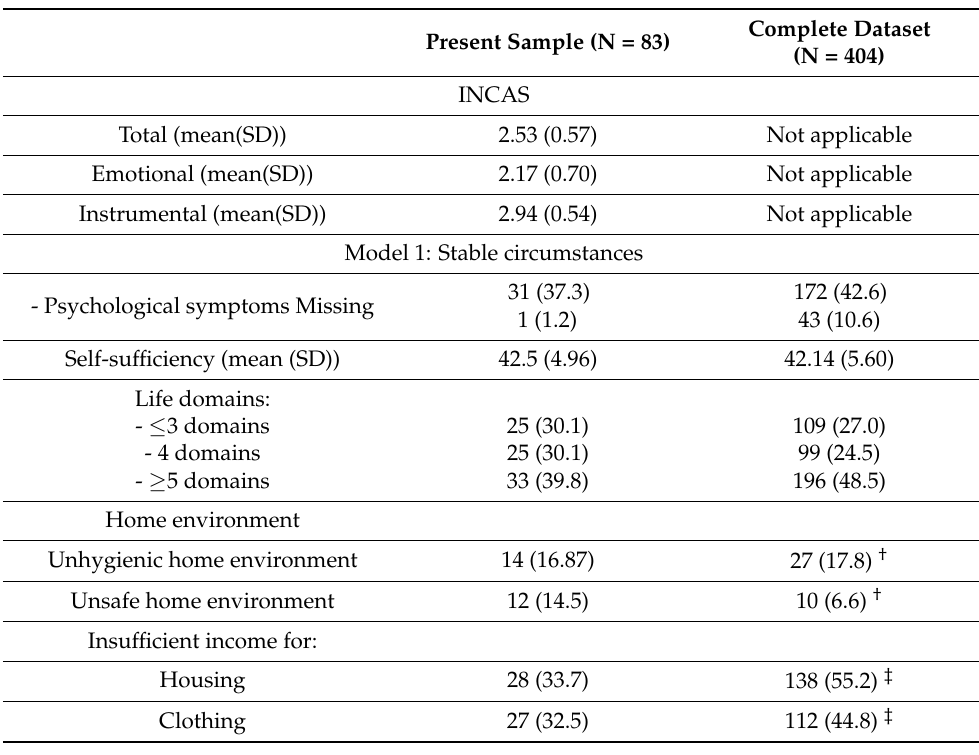
Table 1. Characteristics of the present study sample compared to the overall Mothers of Rotterdam